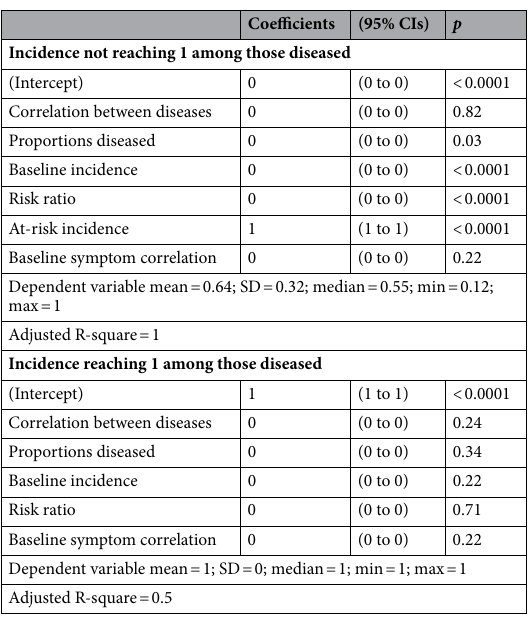
Table 5. Effects of baseline incidence, proportions diseased, risk ratios, and baseline symptom correlations on the sensitivities of individual symptoms for disease diagnosis. CI confidence interval, SD standard deviation.